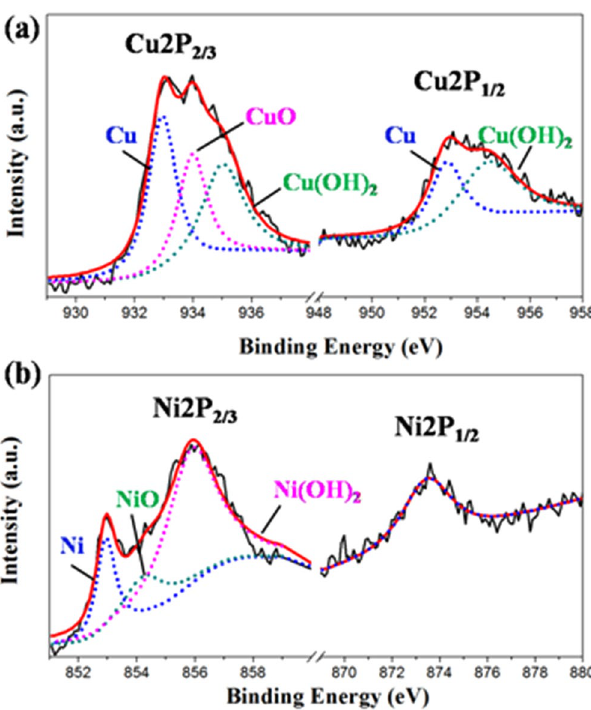
Figure 2. The XPS spectra of Cu@Ni NWs. Cu 2p ( a ) and Ni 2p ( b